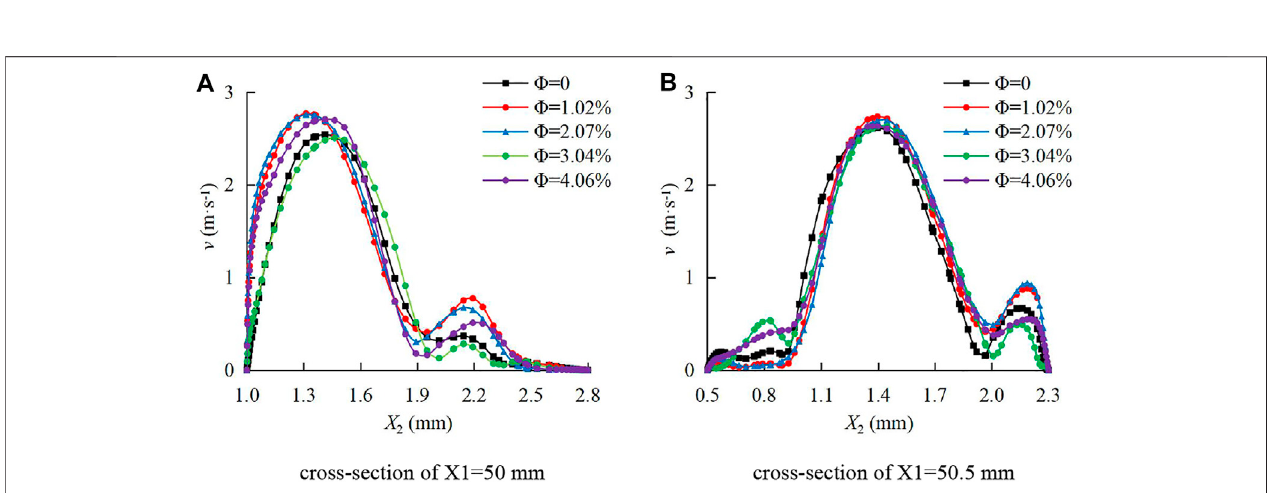
FIGURE 8 | Mean velocity distribution of the continuous-phase fl uid on cross sections of the rough fracture with different sediment volume concentrations. (A) Cross section of X1=50 mm; (B) cross section of X1=50.5 mm.